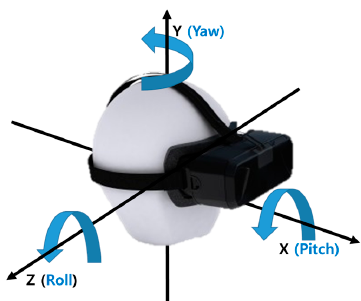
Figure 7. Euler angles and coordinates in the HMD system.